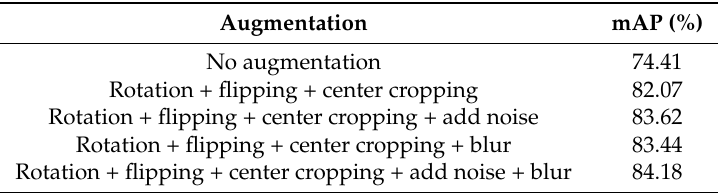
Table 5. Influence of data augmentation on performance.